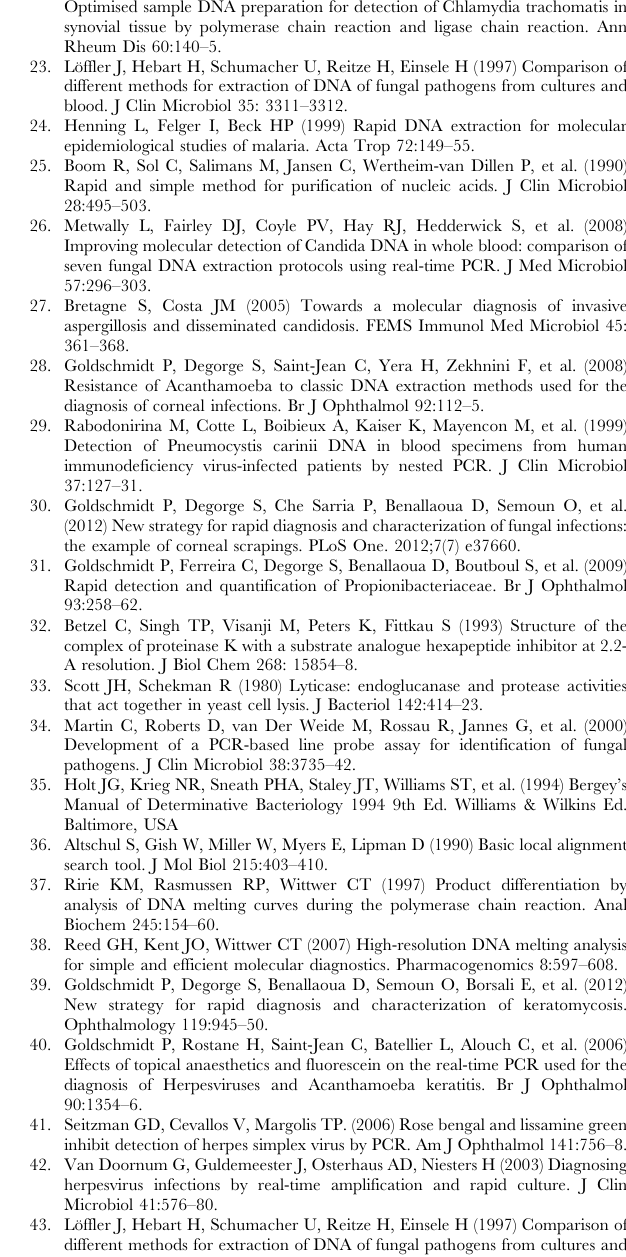
Table S1 Polymerase chain reaction (PCR) results of suspensions spiked with Bacteria after treatment with proteinase K and/or lyticase. Table S2 High resolution melting real-time PCR (HRM) results of suspensions spiked with yeast or filamentous Fungi after treatment with proteinase K and/or